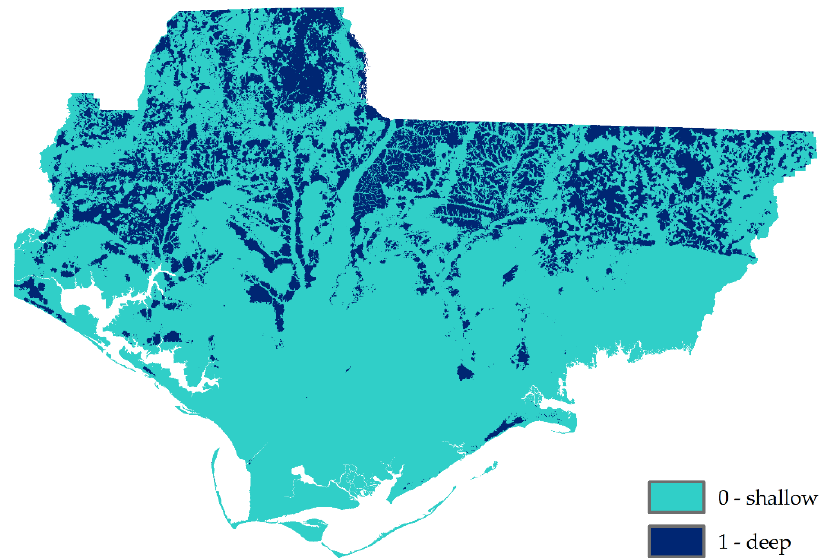
Figure 3. Categorical depth to water table (DTW) raster for the study area. This binary raster shows the shallow (<5 m) water tables as 0 and the deep water table (≥5 m) as 1.